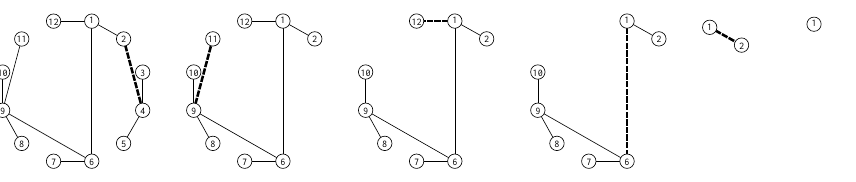
Fig. 2: Destroying in 5 steps a non-crossing tree of size 12 (dotted lines mark edges, that will be removed